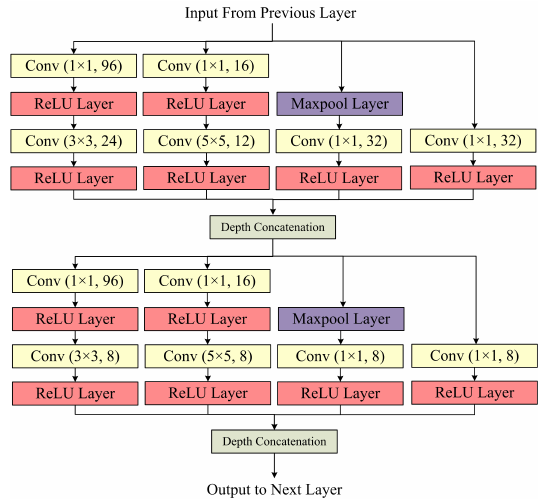
Figure 2. The inception